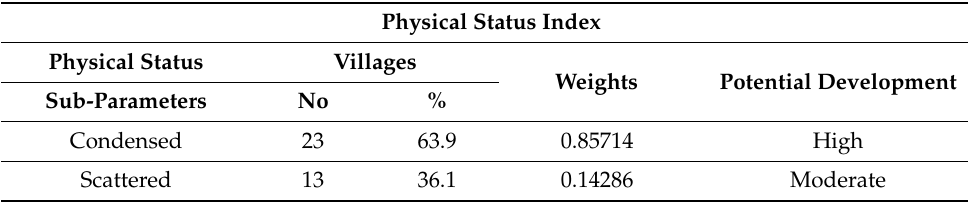
Table 7. Classification of the “Physical Status” index with their weights assigned by the experts.